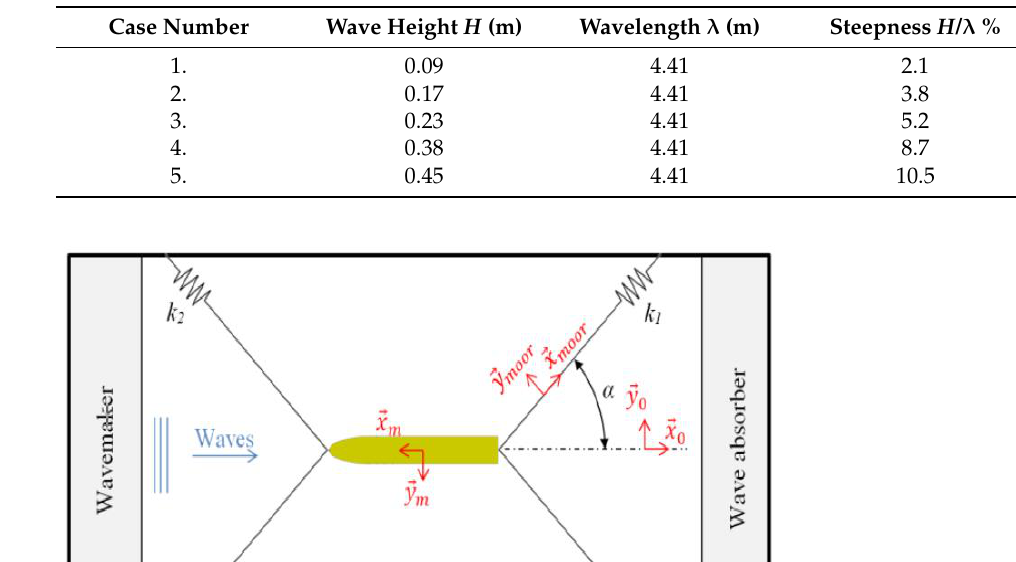
Table 2. Wave conditions from 6750 TEU containership benchmark study (model scale).